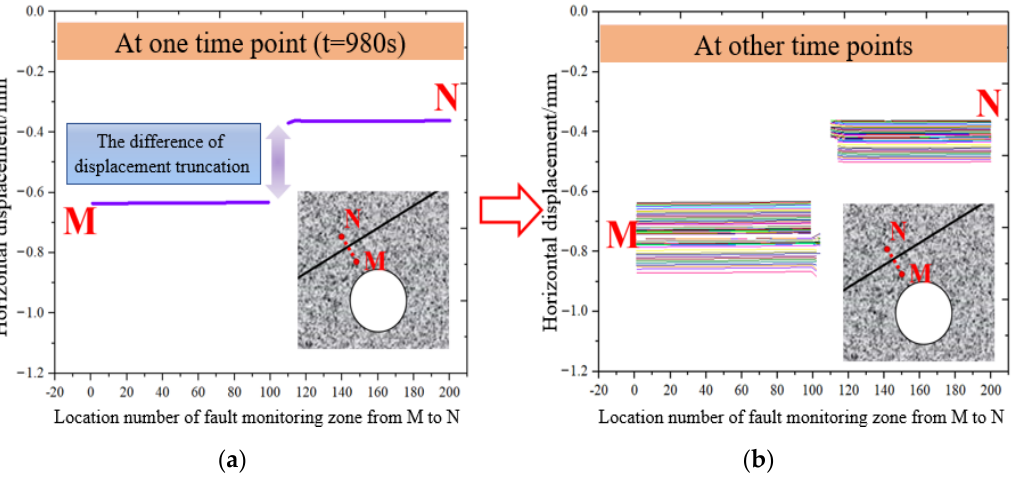
Figure 13. The horizontal displacement drops of granite sample A ‐ 0 during 950 s~1088 s. ( a ) The horizontal displacement drops when t=980 s; ( b ) The horizontal displacement drops when other time points